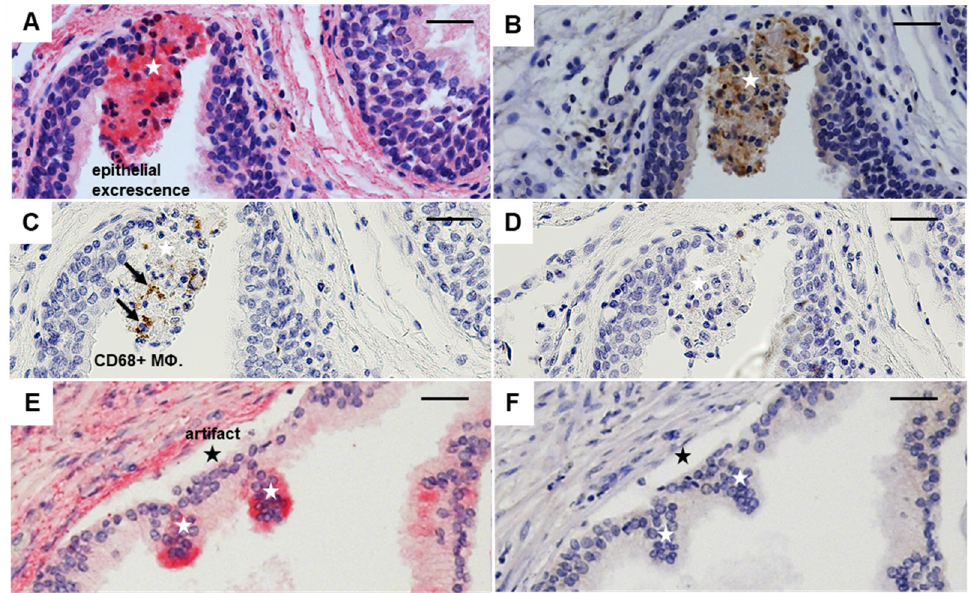
Figure 7. Epithelial cells with luminal excrescences in the prostatic gland. Representative immunohistochemistry of serial sections of GS6 PCa ( A – D ) or BPH ( E , F ), stained with GDF-15 ( A , E ), PD-L1 ( B , F ), CD68 ( C ), CD163 ( D ). White stars mark epithelial excrescence and black stars an artifact; black arrows indicate CD68+ M Φ . Nuclei were counterstained with hematoxylin; scale bar 100 µm.